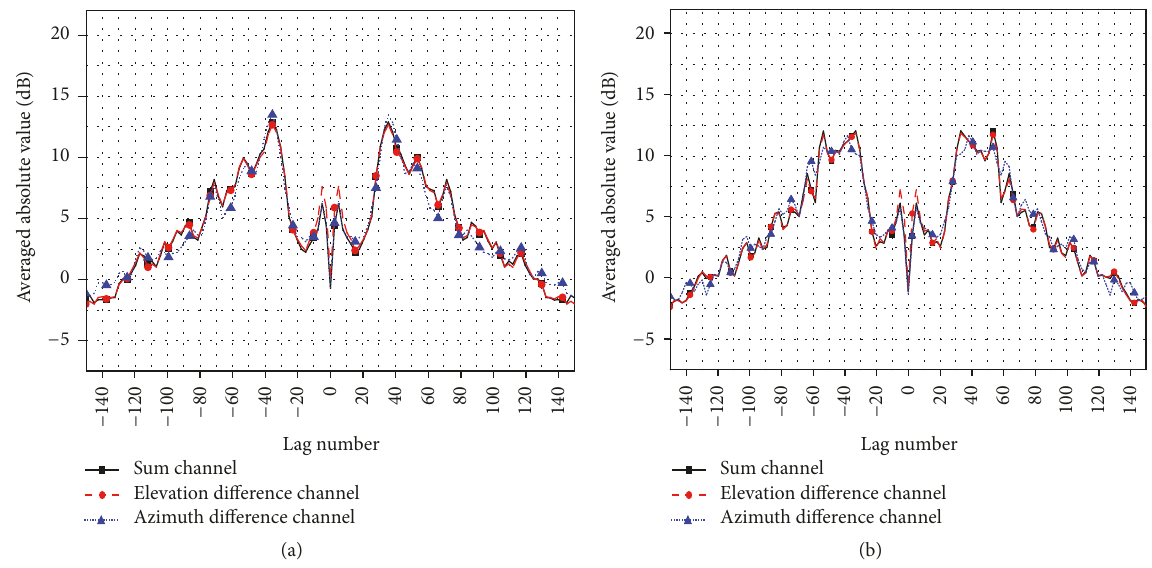
Figure 17: The averages of the power spectra of the spatial correlations of the texture for DS1 and DS2: (a) DS1. (b) DS2.